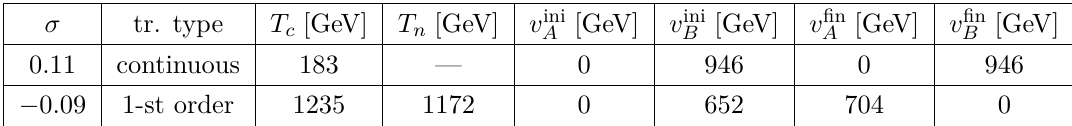
Table 2. Parameters characterizing phase transition obtained for benchmark points from table 1 (for visualization see diagrams in figure 1). For the case with negative σ we have computed the full instanton solution and used it to obtain the temperature at which the bubbles of the new phase start nucleating which we refer to as nucleation temperature T n . As one can see, it only slightly differs from the critical temperature. v ini ( v fin ) corresponds to the VEV of h I at the beginning (end) I I of the phase